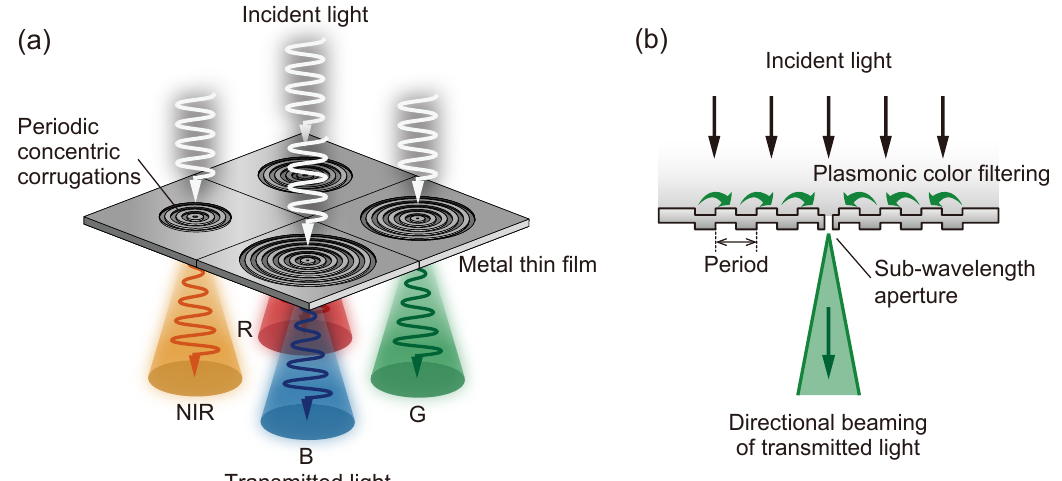
Figure 1. ( a ) A schematic of the proposed multiband plasmonic color filter. ( b ) The mechanism of selected wavelength transmission by surface plasmon coupling.